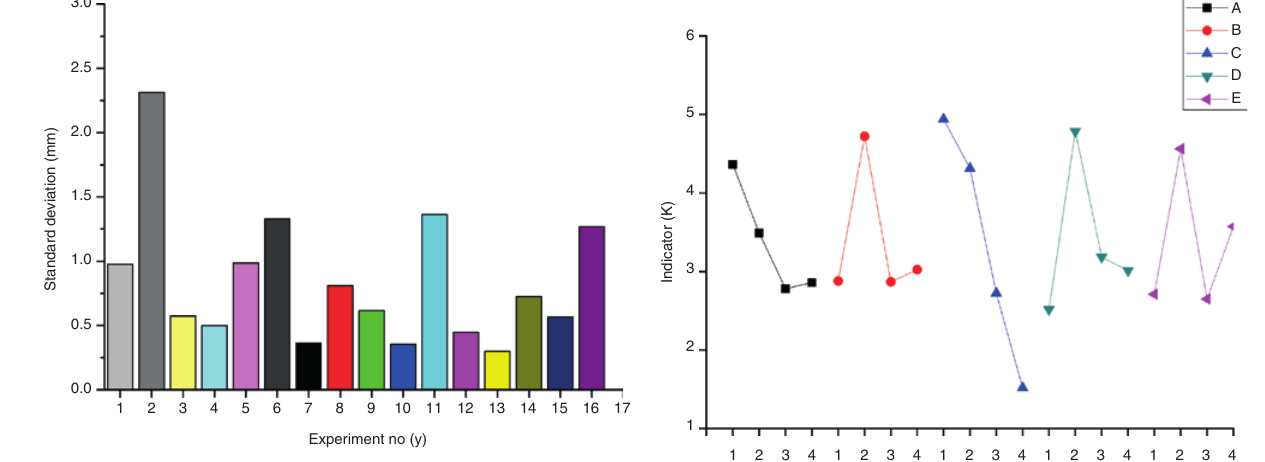
Figure 8: The standard deviation distribution of 16 schemes. Table 7: Analysis results of range of the experiment data.